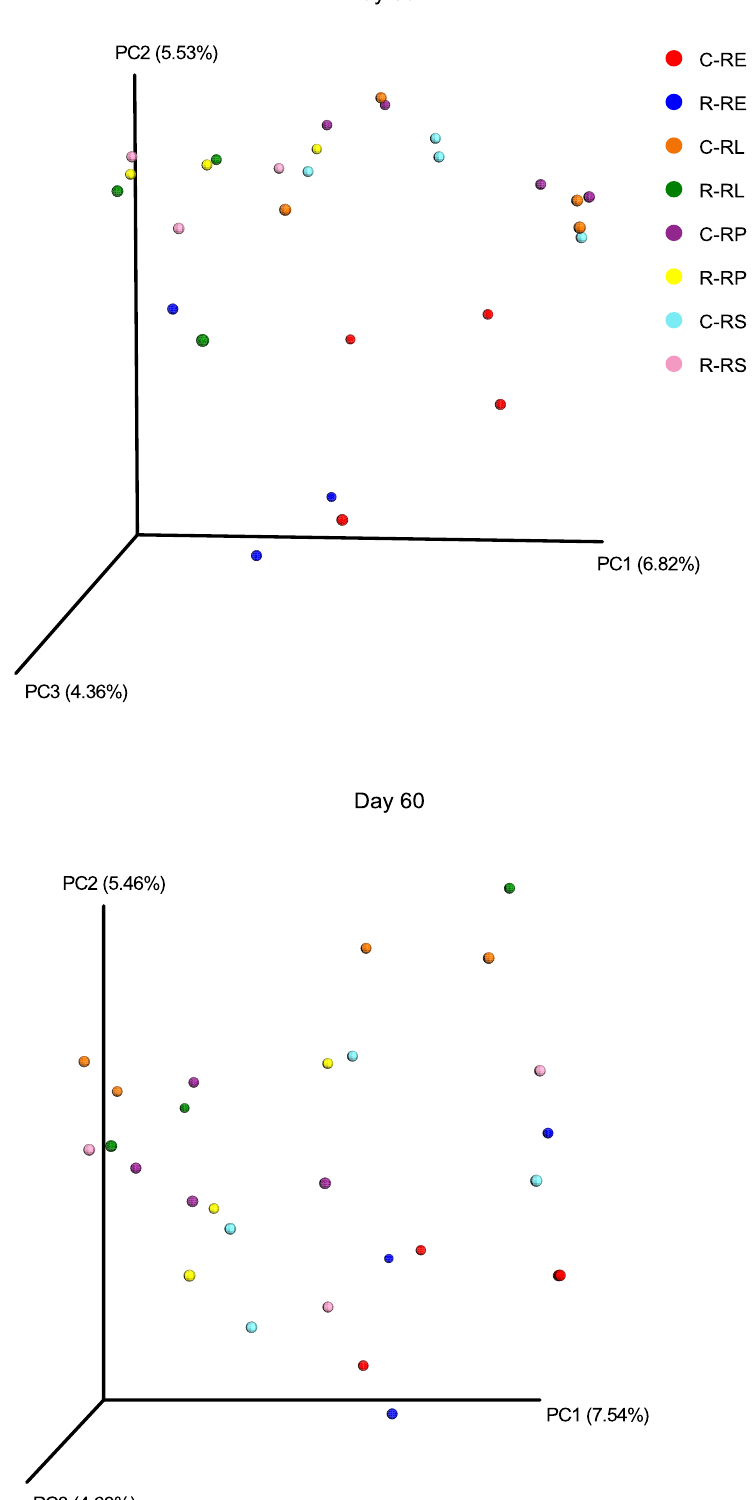
Figure 4. Principal coordinate analysis (PCoA) of methanogen community structure using unweighted Unifrac matrix between two treatments (control diet [C] and rhubarb supplementation [R]) on 50 d and 60